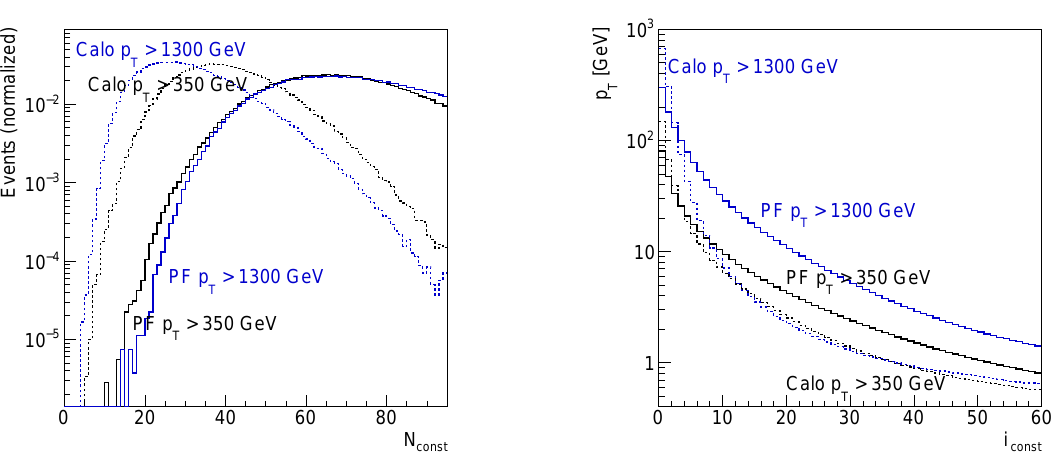
Figure 2: Number of constituents (left) and mean of the transverse momentum (right) of the ranked constituents available as 4-vectors in Eq.(1). We show 4-vectors for the top signal from calorimeter cells or jet images (dashed) and from calorimeter and tracker information combined through particle flow